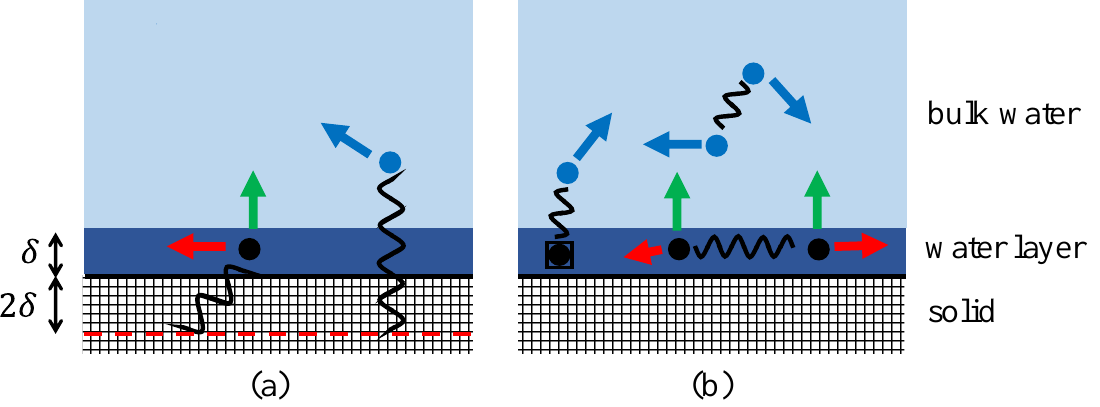
Figure 2. The arrows represent in-layer spin diffusion (red), desorption (green) and bulk diffusion (blue). In ( a ), a measurement of the relaxation rate R 1 ( f ) is dominated by the interaction of fixed paramagnetic impurities with both the water in the surface layer and in bulk. The density of paramagnetic impurities is modelled by a single effective layer (dashed line) placed 2 δ below the surface. In ( b ), R 1 ( f ) is due to layer–layer, bulk–bulk and bulk–layer interactions. The surface layer of water is assumed to be δ = 0.27nm